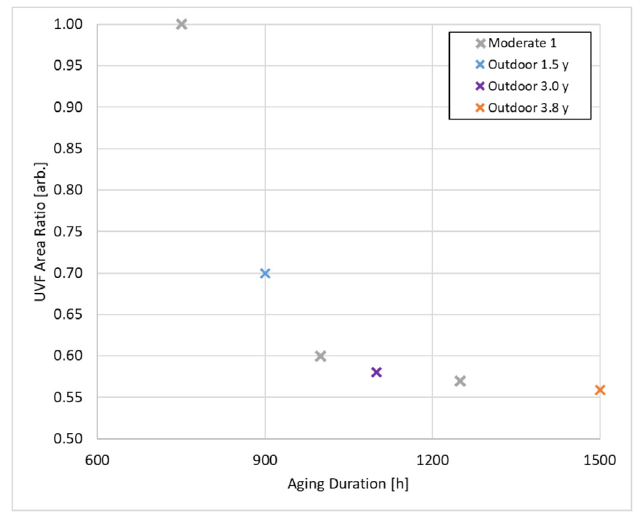
Fig. 13. Analysis of aging duration and UVF area ratio of a naturally aged PV module in combination with arti fi cially aged test